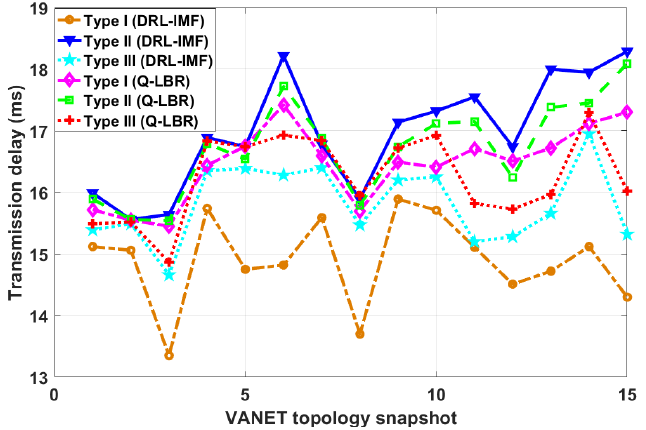
Figure 4. Performance comparison of the proposed strategy for three message types under random topology